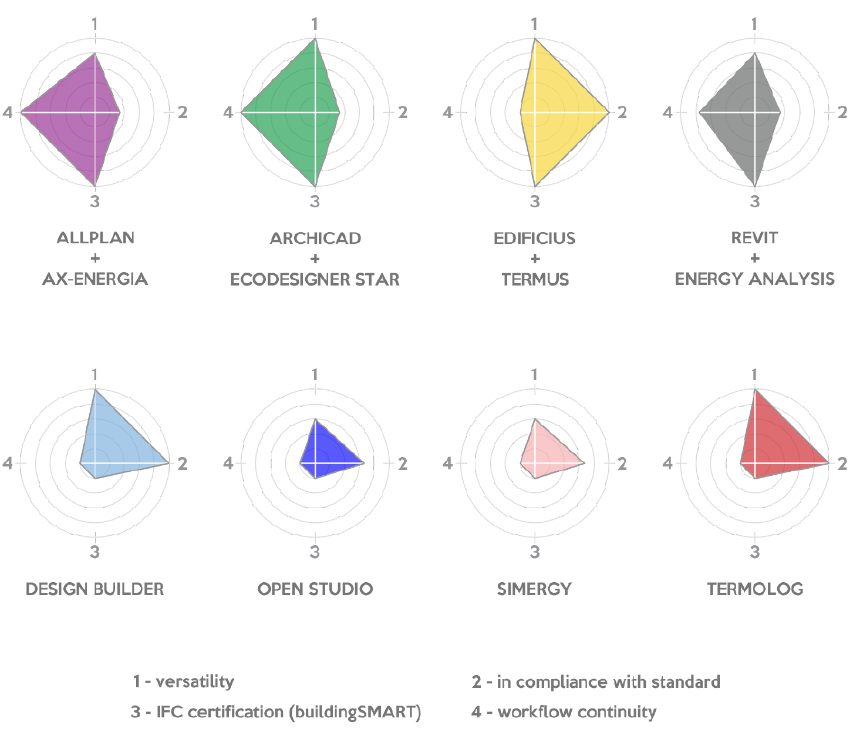
Figure 2. Comparison of the analyzed tools.